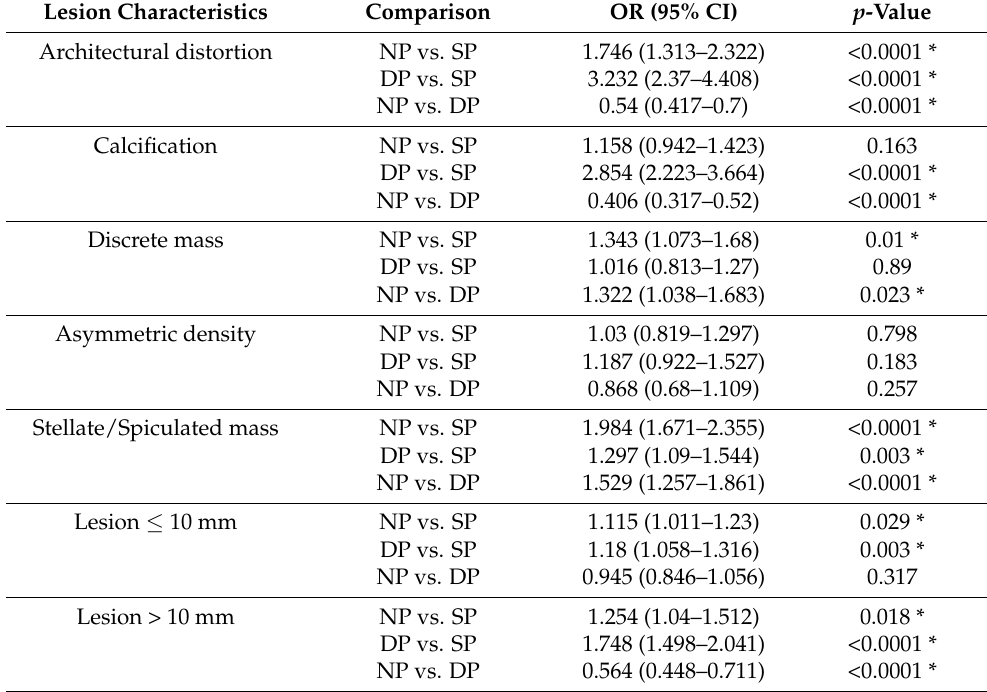
Table 5. Relative Odds Ratio (OR) of true positive lesion localization on mammograms in a compari- son of cases without prior images, with prior images from the same vendor and with prior images from a different vendor.